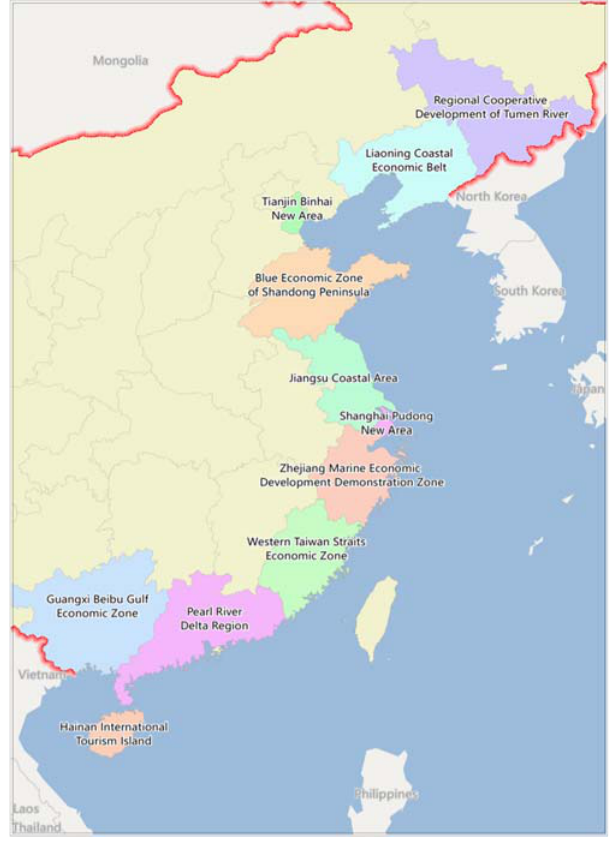
Figure 1. Regional